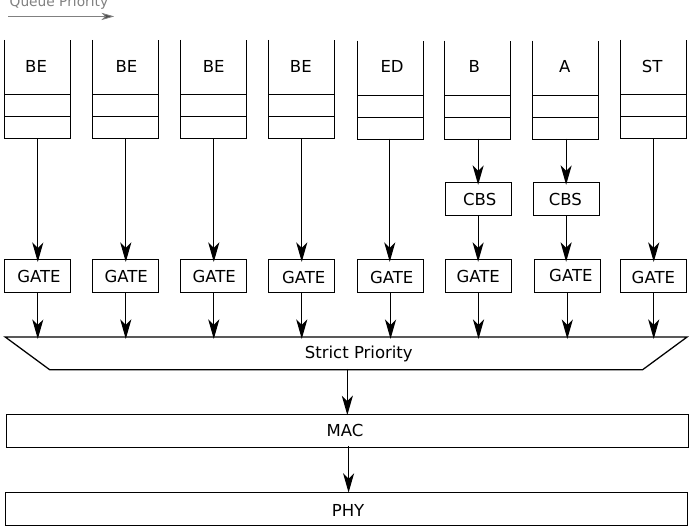
Figure 1. Alternative approach: event-driven (ED) traffic as best-effort (BE) highest